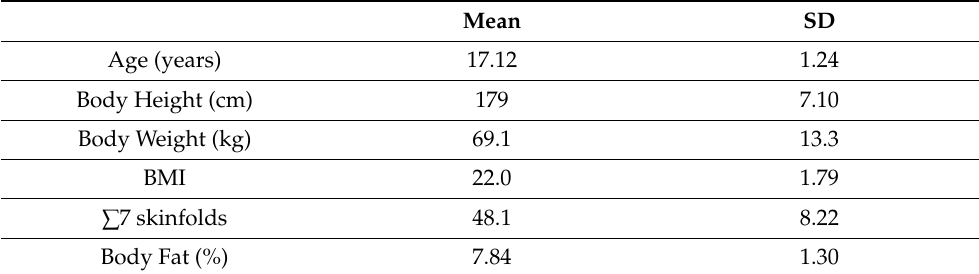
Table 1. Descriptive statistics of body composition of the total